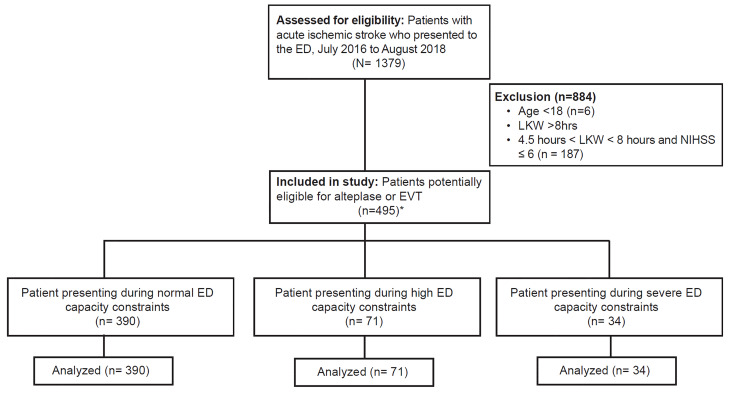
CONSORT diagram for patient inclusion criteria by study outcome.*DIT analysis includes 298/495 patients who were non-transfers.ED, emergency department; LKW, last known well; NIHSS, National Institutes of Health Stroke Scale; EVT, endovascular therapy; DIT, door-to-imaging time.